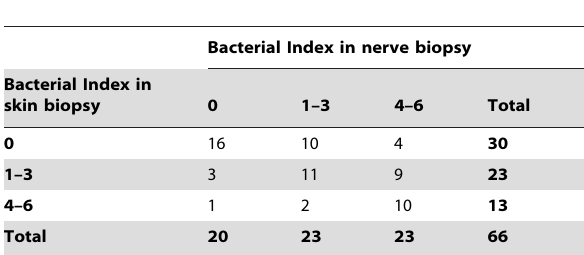
Table 5. Comparison of Bacterial Index in skin and nerve